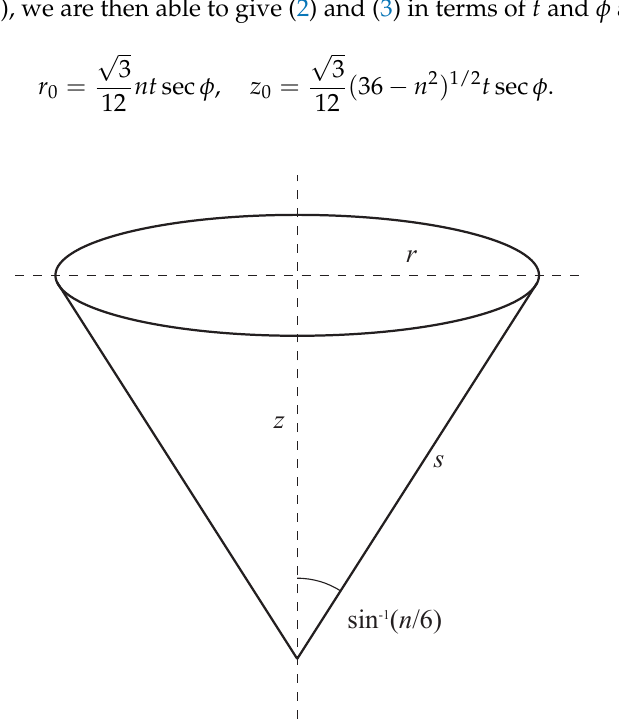
Figure 2. Geometry of the right circular cone showing the radius ( r ), height ( z ), and slant length from vertex s (the cone angle is determined from number of panels ( n